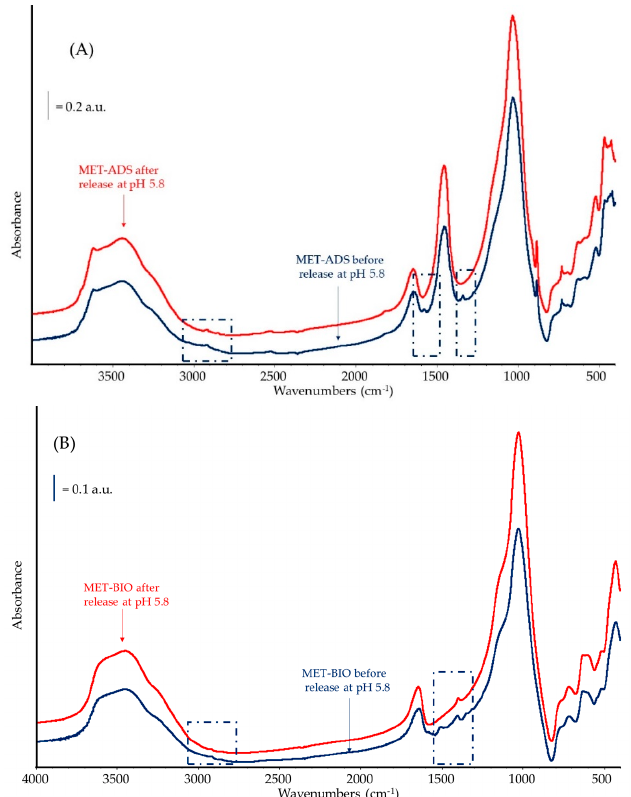
Figure 2. Spectral regions of infrared spectra obtained by Fourier-transform infrared spectroscopy (FTIR) of released methionine at different pH conditions; ( A ) Met-ADS and ( B ) Met-BIO before and after release at pH 5.8 (dashed areas: bands of interest). Dashed rectangular: weak IR bands characteristic of the organic moiety near 2920–2950 cm − 1 (CH stretching modes) and in the region 1620–1300 cm − 1 (CO and CN stretching modes, CH deformation